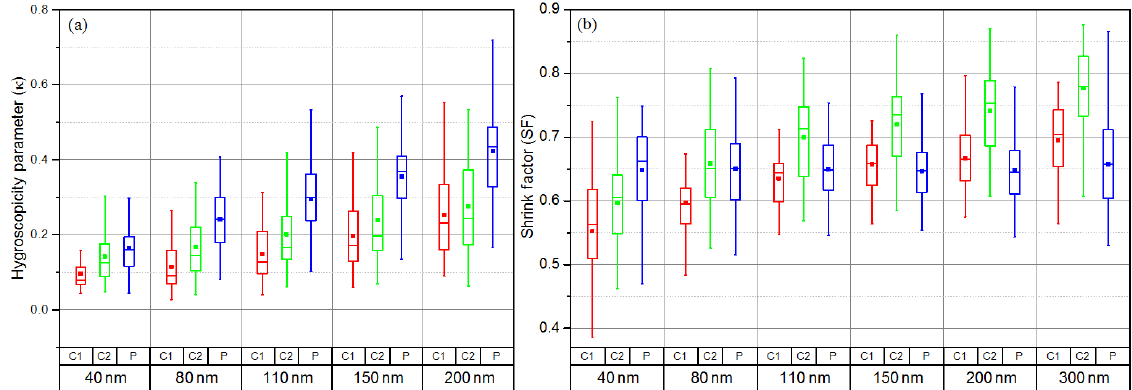
Figure 7. Size-resolved (a) κ and (b) SF during Clean1 (C1), Clean2 (C2), and Pollution ( P ) periods. The figure shows the mean κ or SF (solid square markers) with boxes showing the 25th, 50th, and 75th percentiles. The extremities show the 5th and 95th